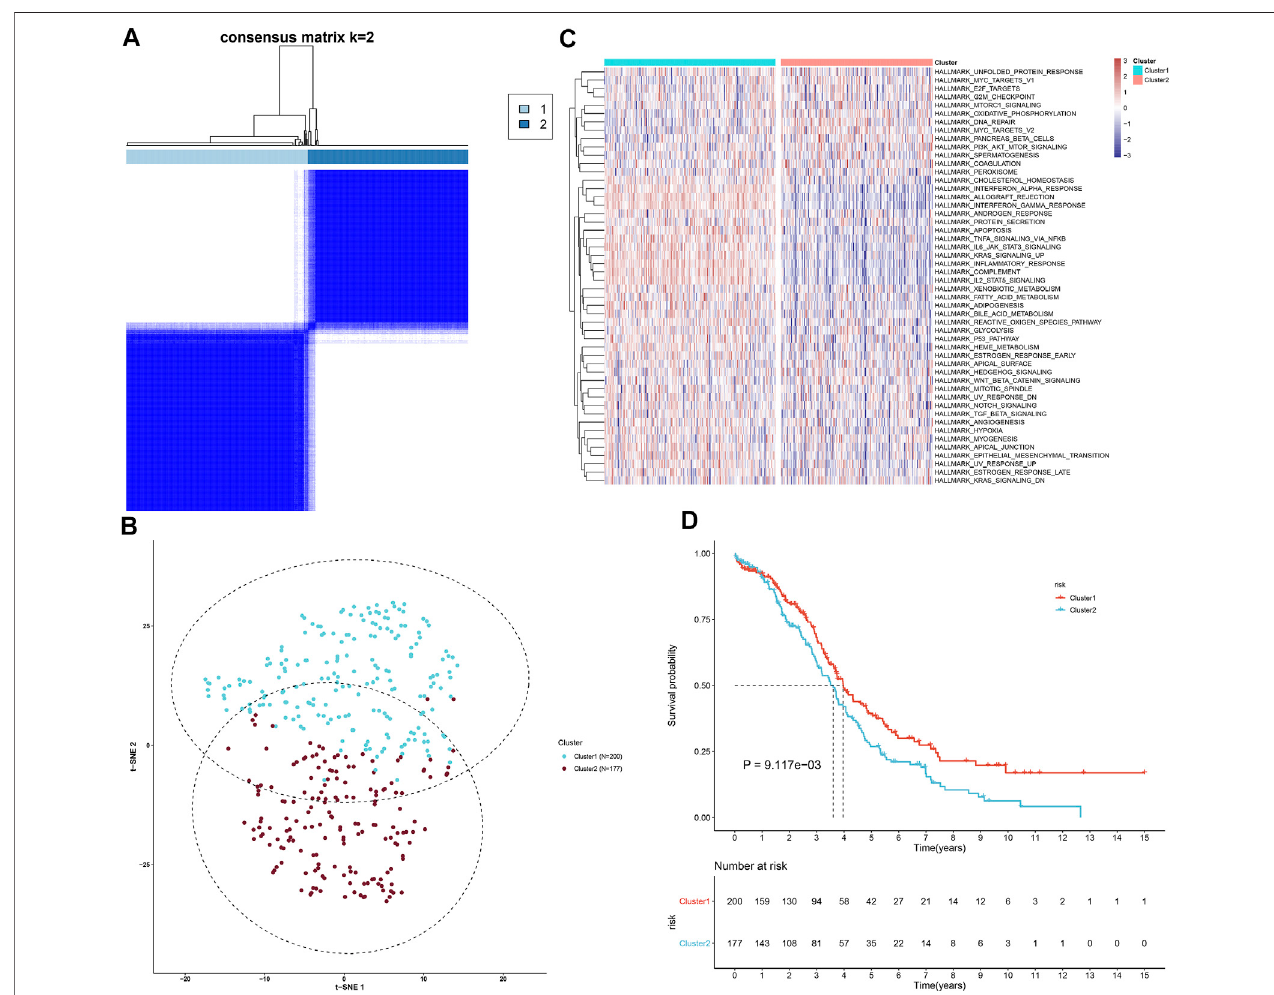
FIGURE 1 | Characterization of diverse immune subtypes of OC patients. (A) Heatmap depicting the sample clustering when consensus k = 2 in accordance with the expression pro fi ling of prognostic immunologically relevant genes. (B) The t-SNE analyses visualizing two discrete immune subtypes with expression matrix of prognostic immunologically relevant genes. (C) Heatmap showing the activation difference in hallmark gene sets between two immune subtypes. (D) Kaplan – Meier analyses for the survival difference between two immune subtypes.